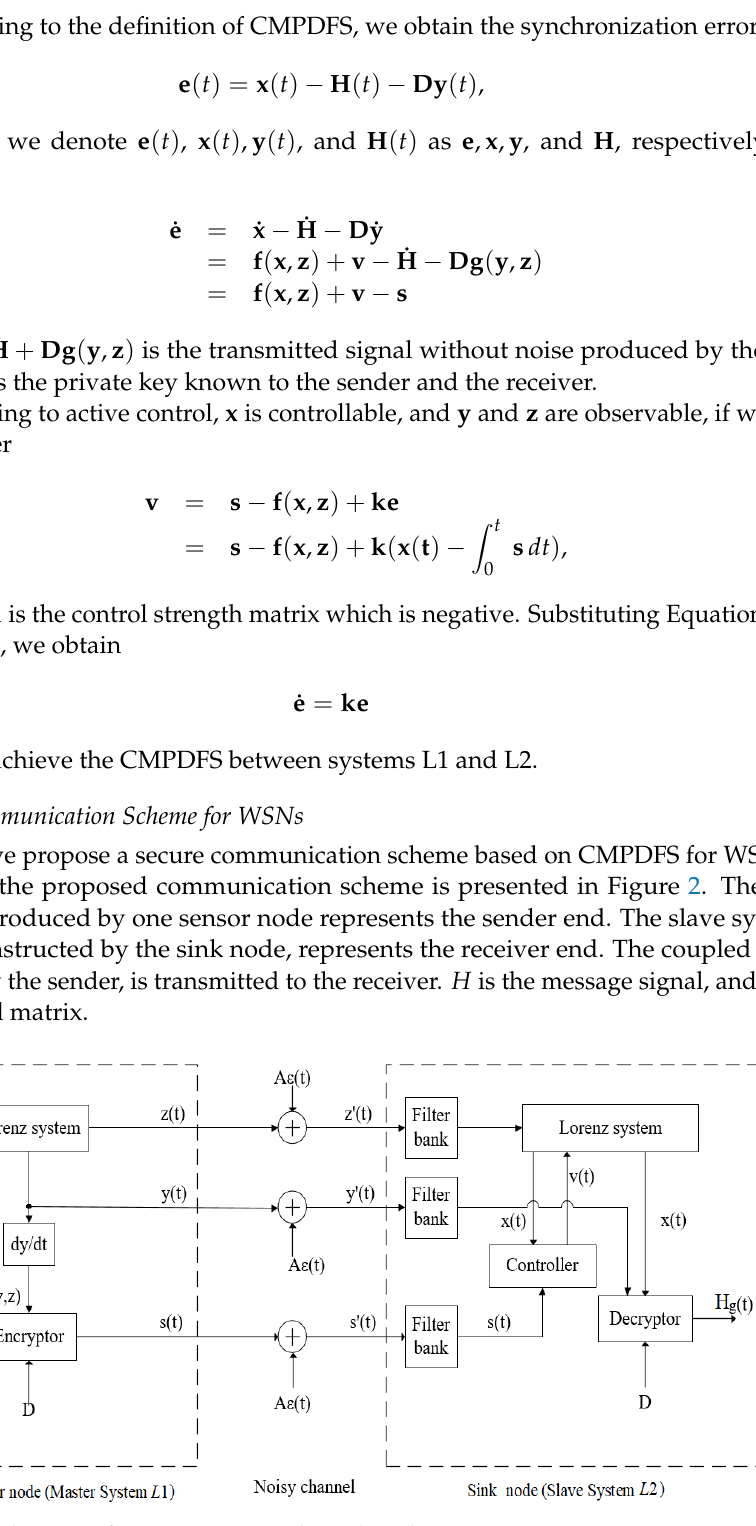
Figure 2. The diagram of communication scheme based on